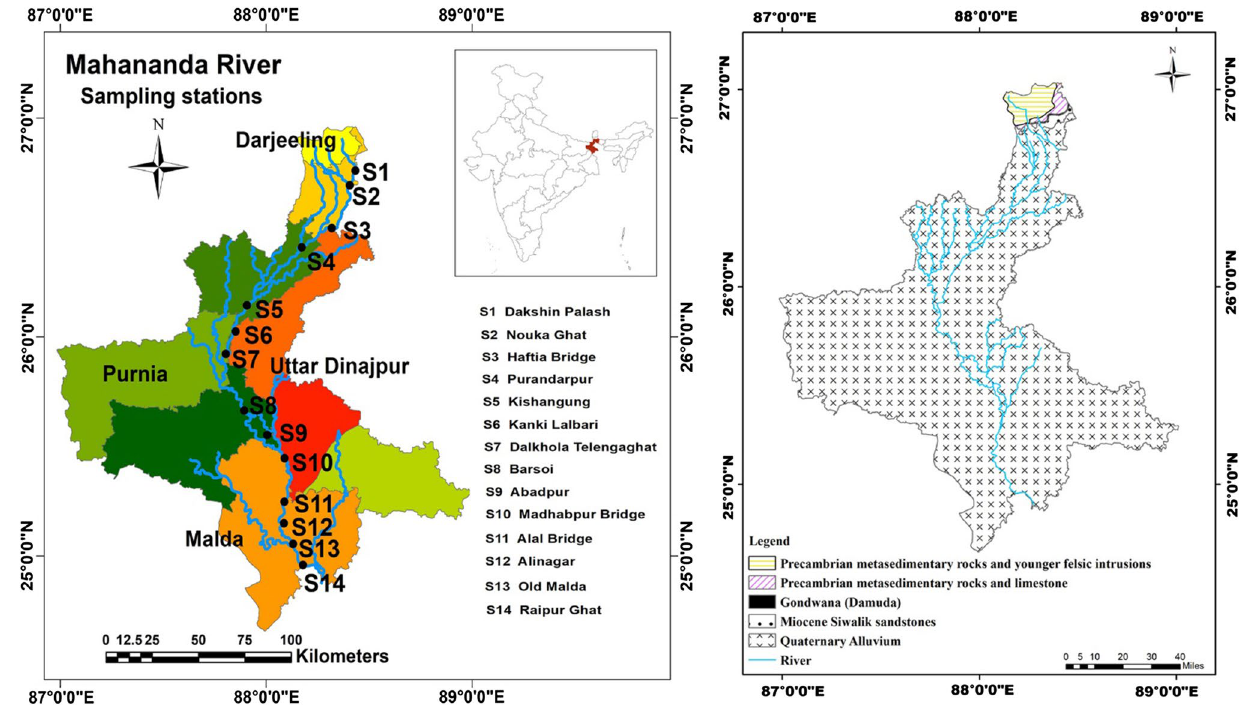
Fig. 1 Map of sampling stations and geological settings of the study